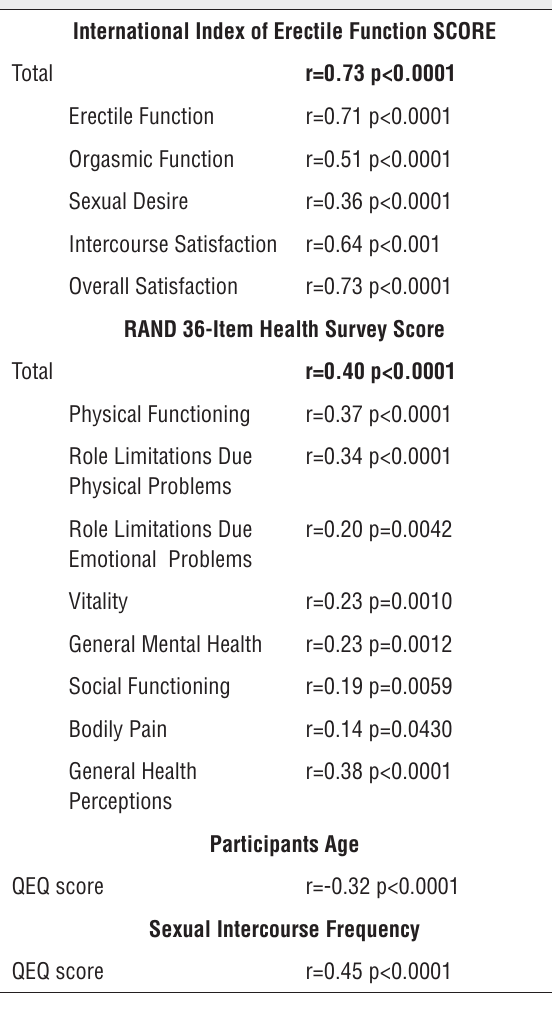
Table 4 - Spearman Correlation (QEQ Versus IIEF, QEQ Versus RAND 36-Item Health Survey, QEQ Versus Aging and QEQ Versus Sexual Intercourse Frequency).